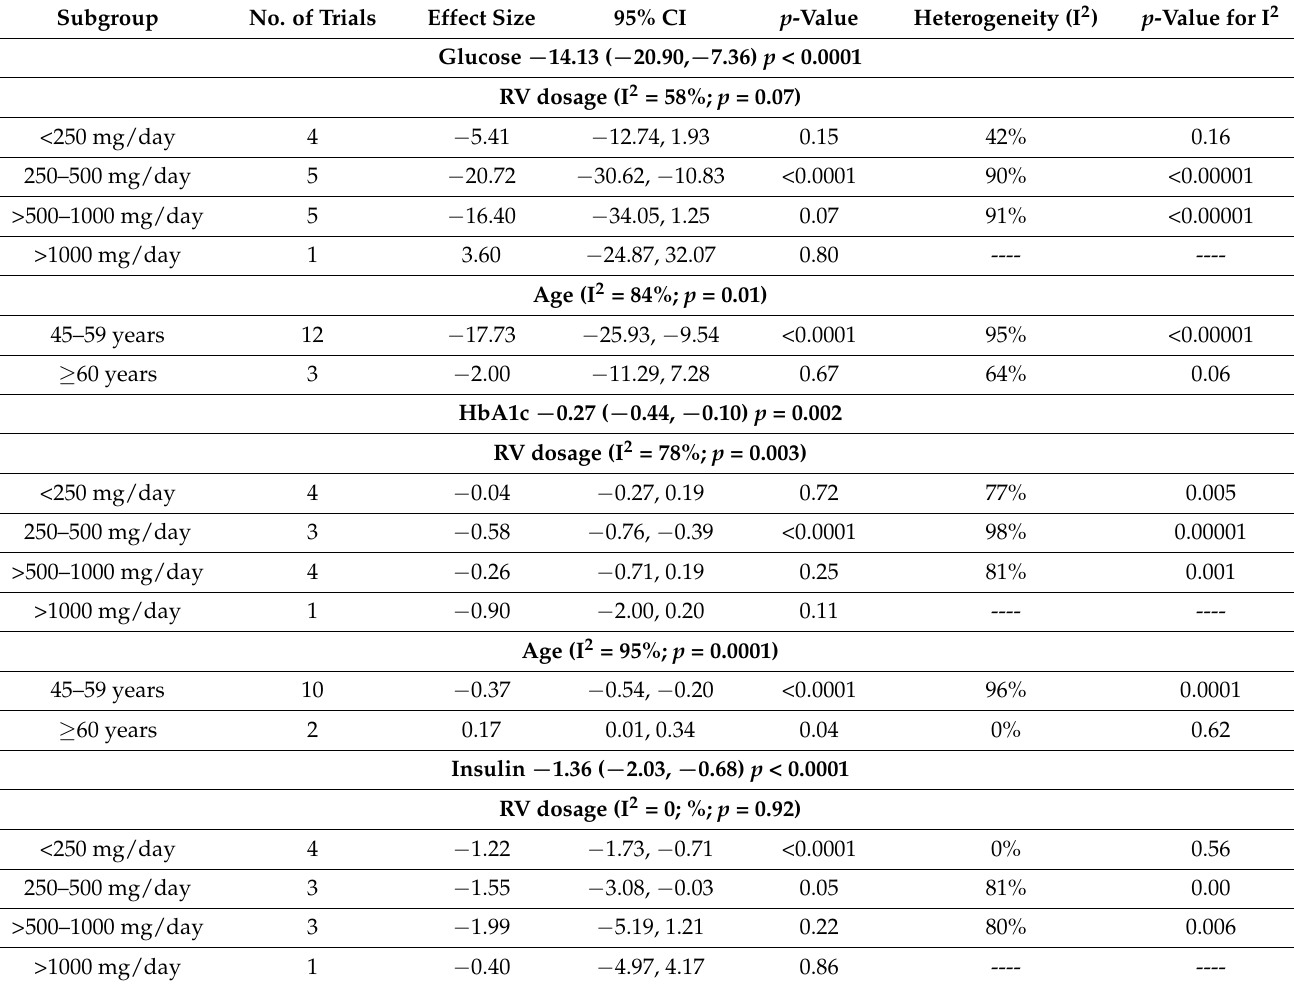
Table 2. Analysis to evaluate the influence of age and dose on the effect of RV in